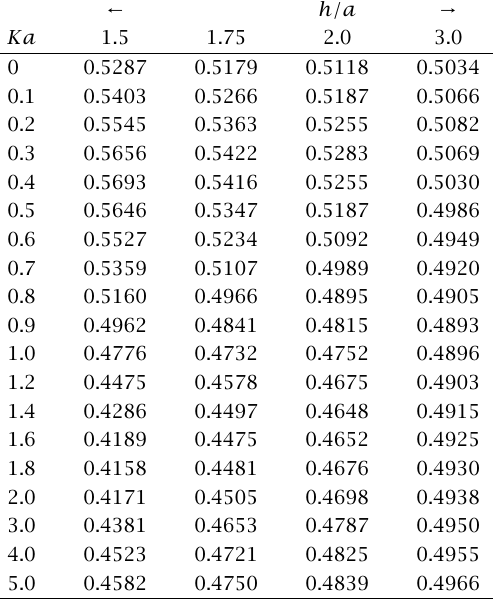
Table 7.1 . Surge added-mass µ 11 for different submergence (h/a) values.